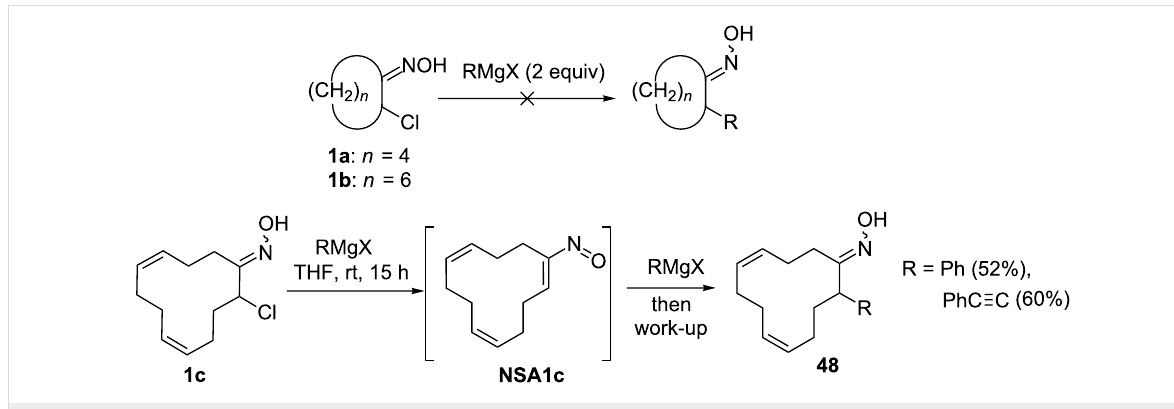
Scheme 16: Reactions of cyclic α -chloro oximes with Grignard reagents.